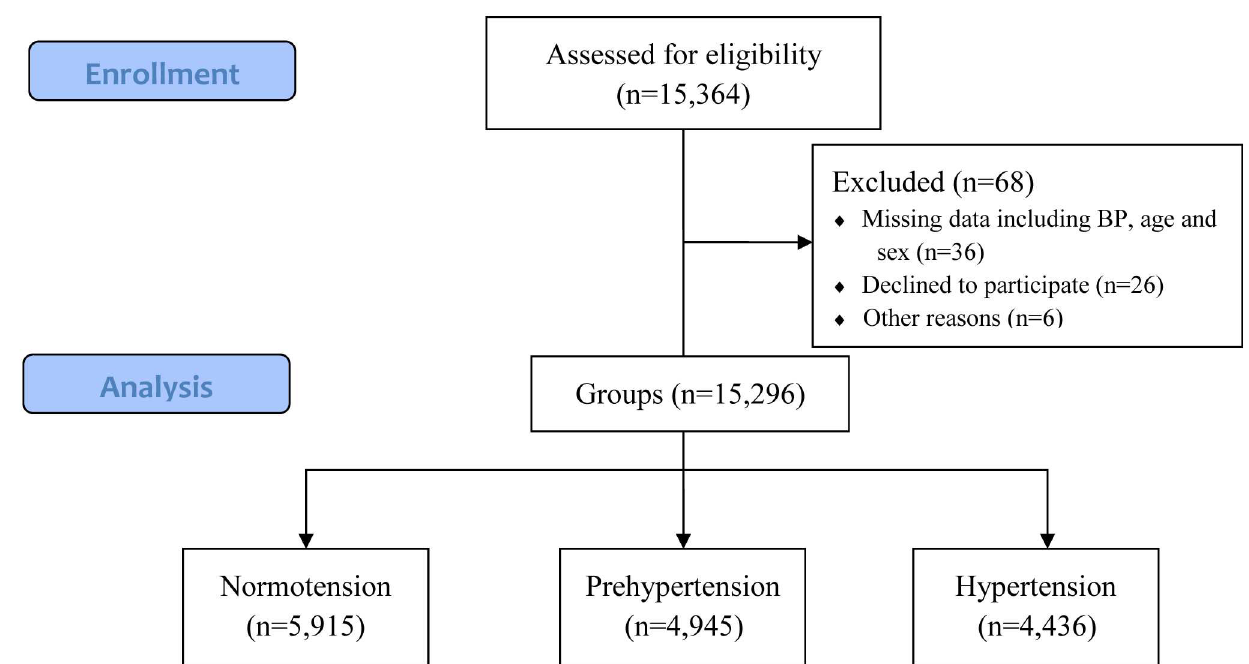
Fig 1. Disposition of patients who were recruited, underwent the groups, and analysed. Sixty-eight participantswere excludedbecause of missing data including sex, age, BP, and so